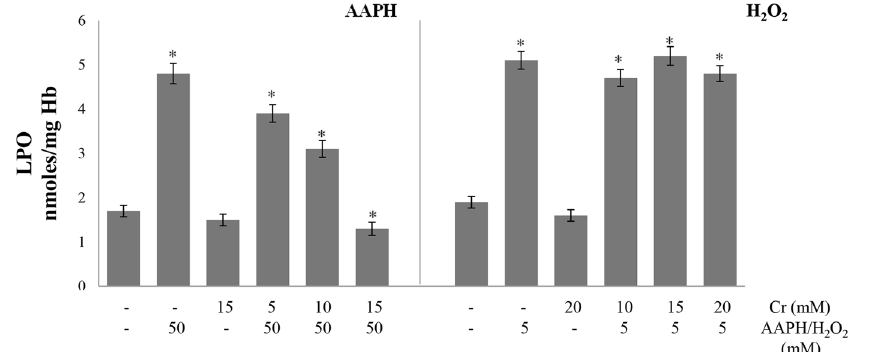
Fig 2. Effect of creatine on AAPH/ H 2 O 2 -induced lipid peroxidation. Erythrocytes were treated with the indicated concentrations of H 2 O 2 /AAPH, in presence and absence of Cr. Malondialdehyde levels were determined in hemolysates as an index of lipid peroxidation. Results are mean values ± SEM from six independent experiments using blood from different donors. * Significantly different from control (p < 0.05). LPO, lipid peroxidation.